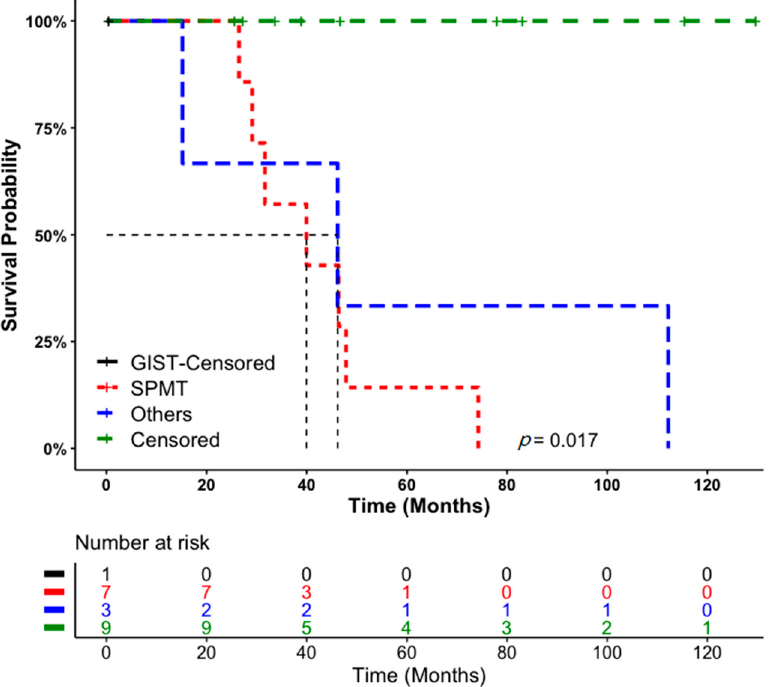
Figure 3. Overall survival analysis of Gastrointestinal stromal tumor (GIST). Second primary malignant tumor (SPMT), and non ‐ tumor causes: Kaplan ‐ Meier survival curves of survival data in relation to the causes of mortality variables, with follow ‐ up duration of more than 6 years after first diagnoses (total n = 20). The numbers of patients at risk at 0, 25, 50, 75, 100, and 125 months for each of three groups are shown in the table immediately below the survival curves.